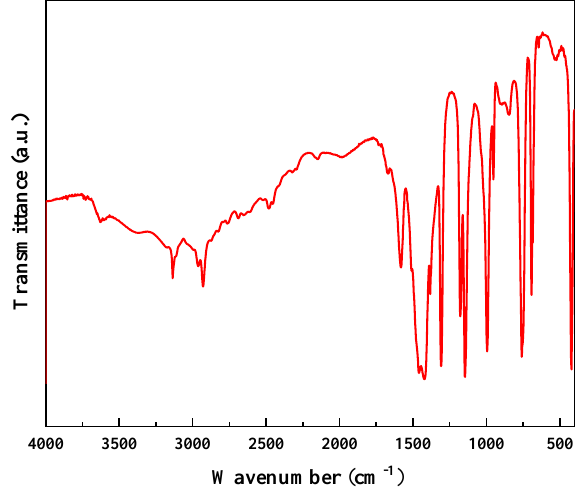
Figure 3. The FTIR spectra related to ZIF-8 nanocomposites.